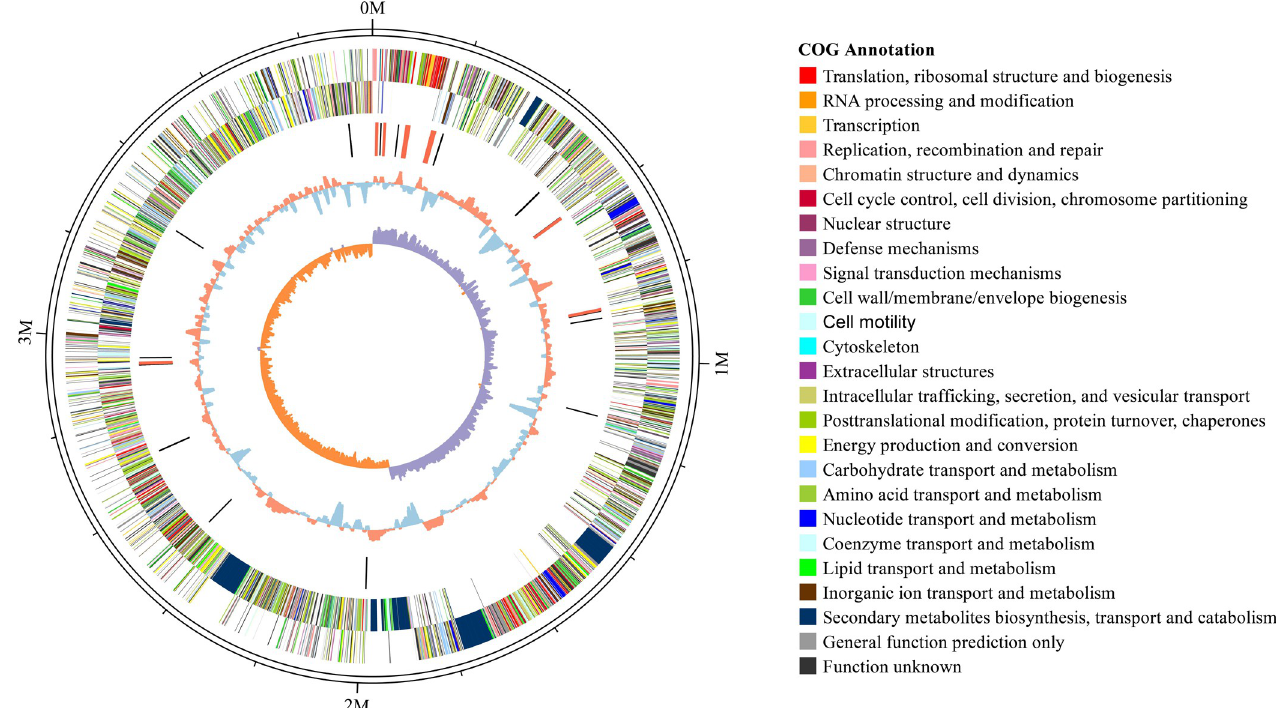
Fig 5. Complete map of the genome of DW-7